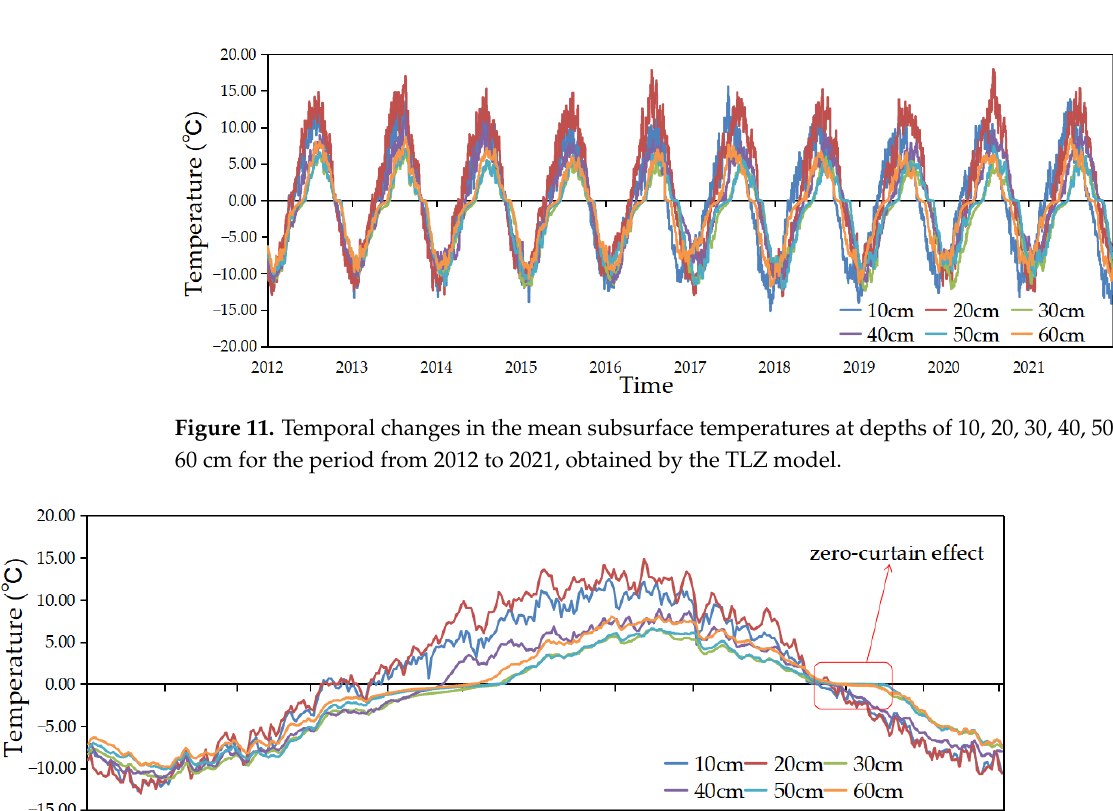
14 of 22 Figure 10. Maximum, minimum and mean of LST maps obtained for each year from MODIS LST products. 3.2.3. Mean Subsurface Temperatures at Different Depths Figure 11 demonstrates the mean subsurface temperatures at the depths of 10, 20, 30, 40, 50 and 60 cm from 2012 to 2021 by the TLZ model, as a function of time. Figure 12 shows those values for 2012, which indicates that the zero-curtain effect was seen at the depths of 30, 50, and 60 cm below ground; however, this effect was not seen at 40 cm depth due to a lack of data. As shown in Figure 12, the subsurface temperatures at different